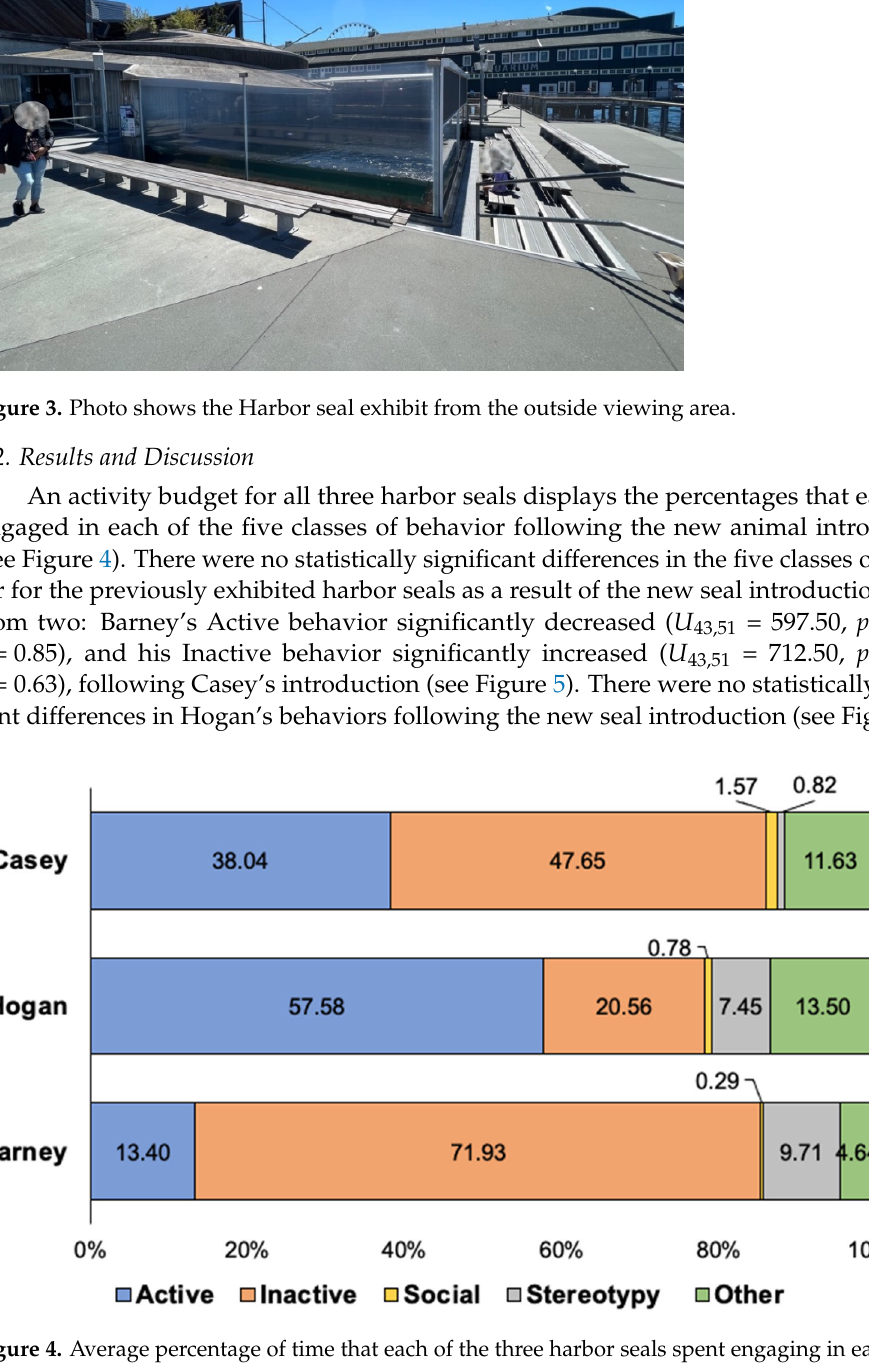
Figure 5. The percentage of occurrence (with standard error of the mean bars) that Barney engaged in each of the five behavior classes, comparing pre ‐ introduction and post ‐ introduction activity lev ‐ els. Solid lines and asterisks represent statistically significant results in accordance with the Bonfer ‐ roni correction for Experiment 1 ( α = 0.004). * p ≤ 0.004. ** p < 0.001.